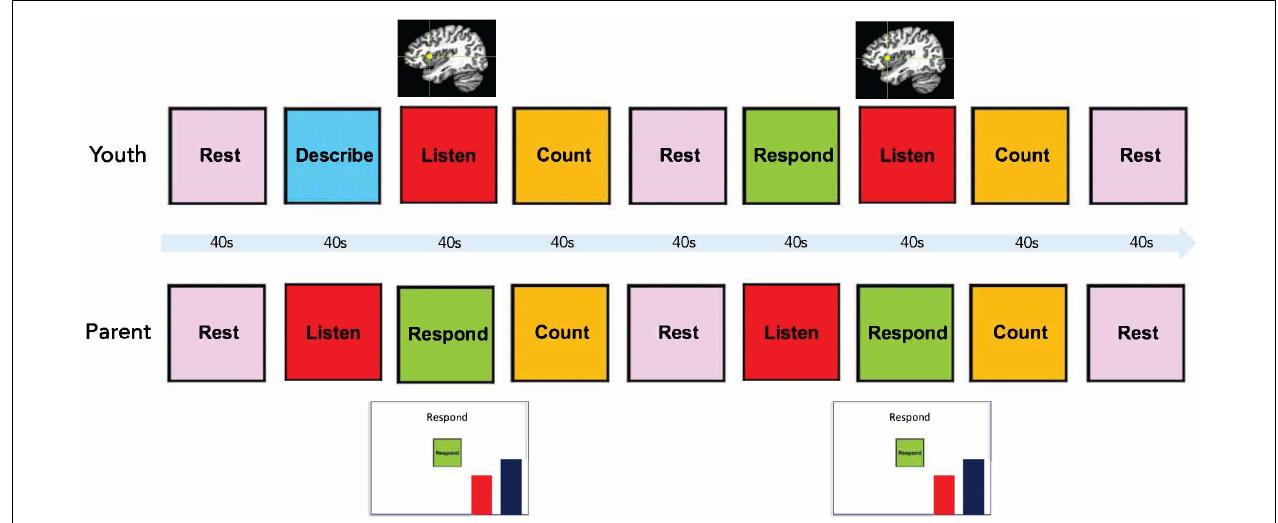
FIGURE 1 | Emotion discussion task design. Each block had a duration of 40 s. During Listen blocks for the adolescent, the mother spoke to the adolescent via an active noise-canceling headset while viewing a moving red bar representing neurofeedback from her daughter’s right anterior